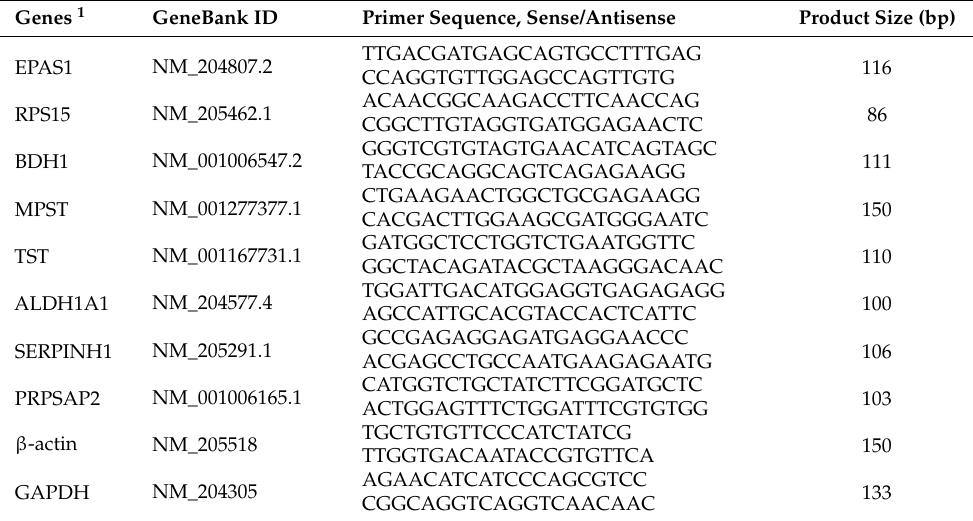
Table 2. Sequences used for real-time PCR